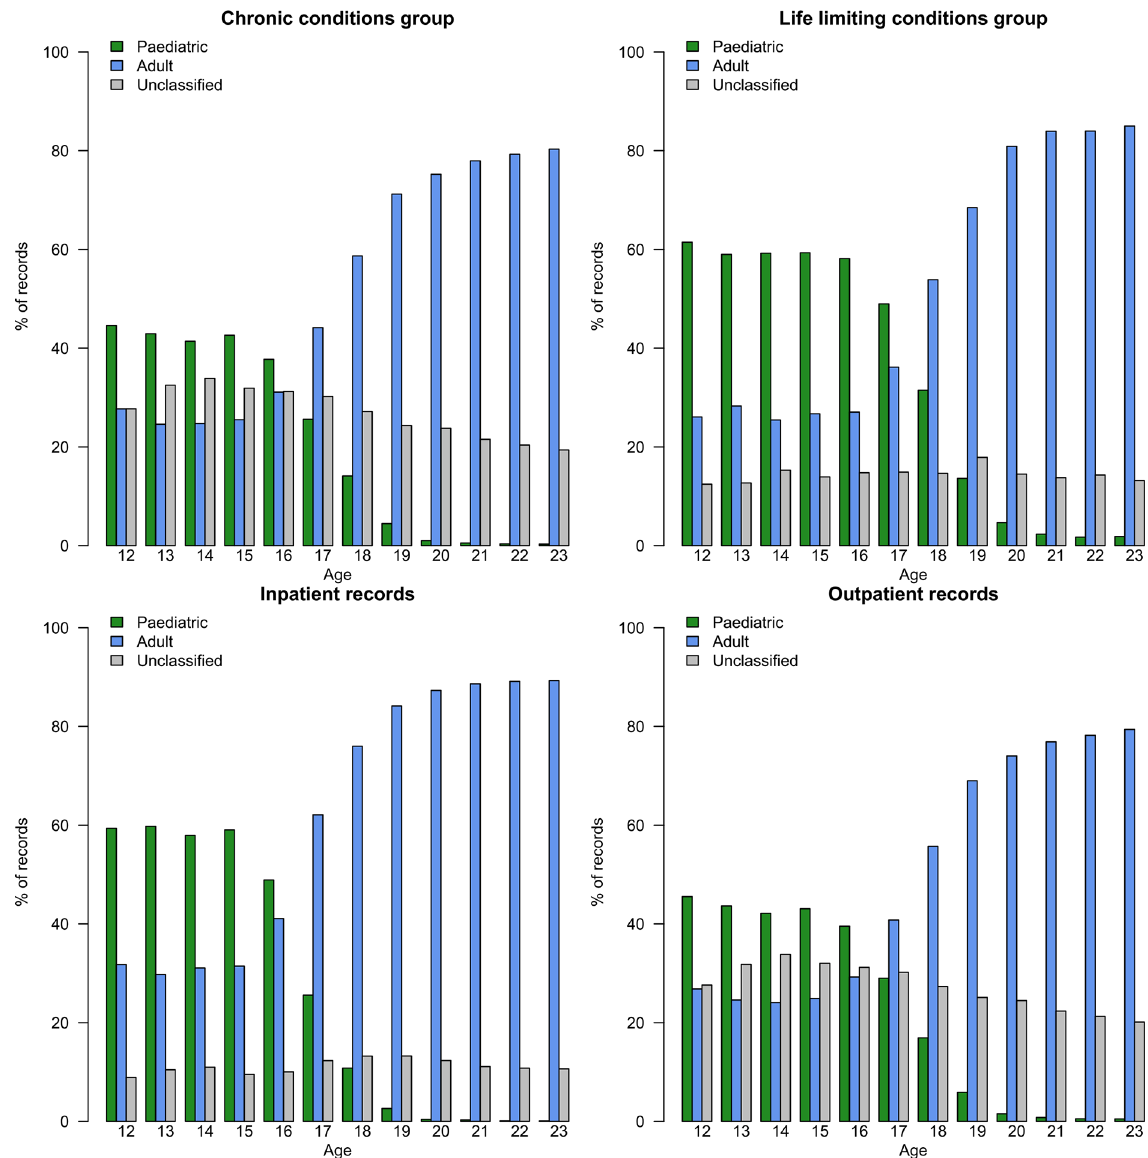
Figure 4: Percentages of records classified as paediatric, adult or unclassified by age in the chronic conditions group (inpatient and outpatient records), the life-limiting conditions group (inpatient and outpatient records), among inpatient records (whole cohort) and among outpatient records (whole